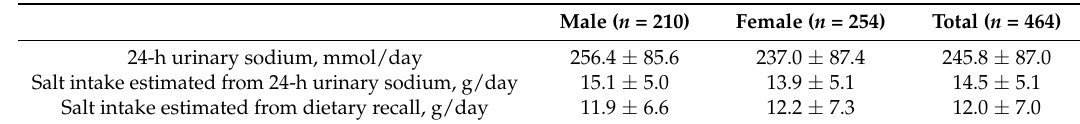
Table 2. Salt intake in a subset of 464 participants with fully completed dietary assessment forms and a valid 24-h urine